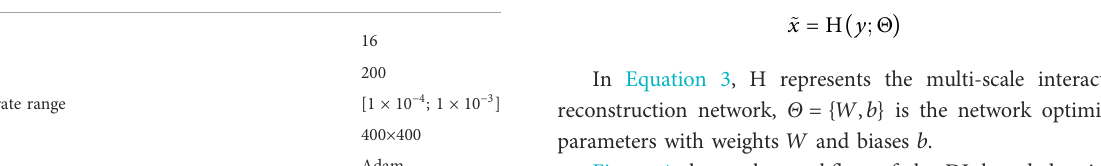
TABLE 3 The details of training the proposed network.